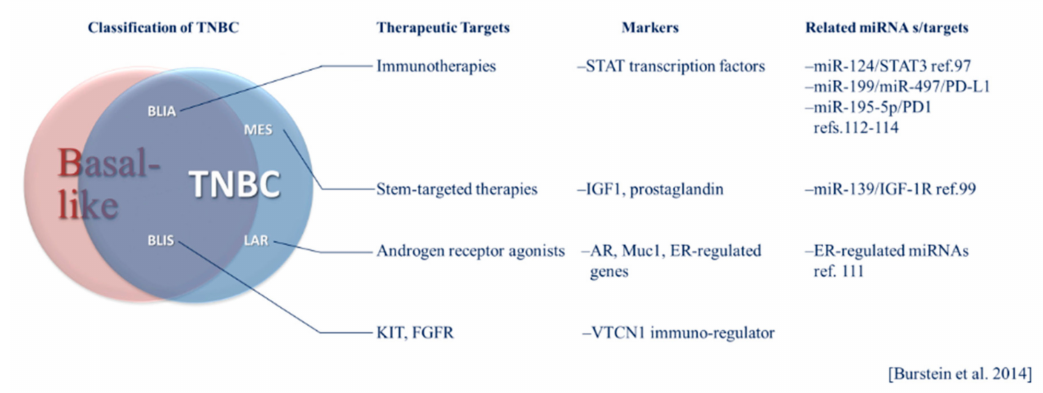
Figure 1. The Burstein system of triple-negative breast cancer (TNBC) classification and its relationship to basal-like breast cancer. General targeted therapeutic considerations, molecular markers and microRNA (miRNA) specific to TNBC subtypes are